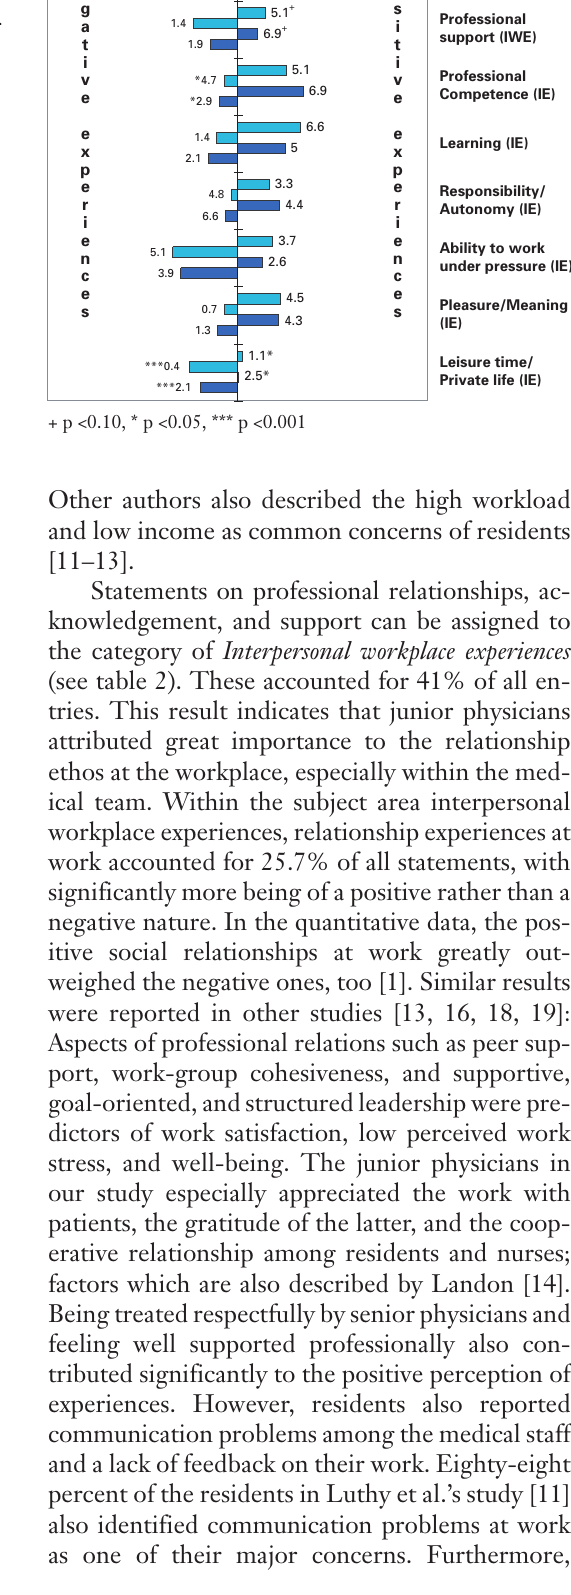
Figure 1 Gender-divergent fre- quency distribution of responses for positive and negative professional experi- ences with reference to the total number of responses for each sex (total responses of females, n = 1,063; total responses of males, n = 798), cate- gories in the order of the three superor- dinate subject